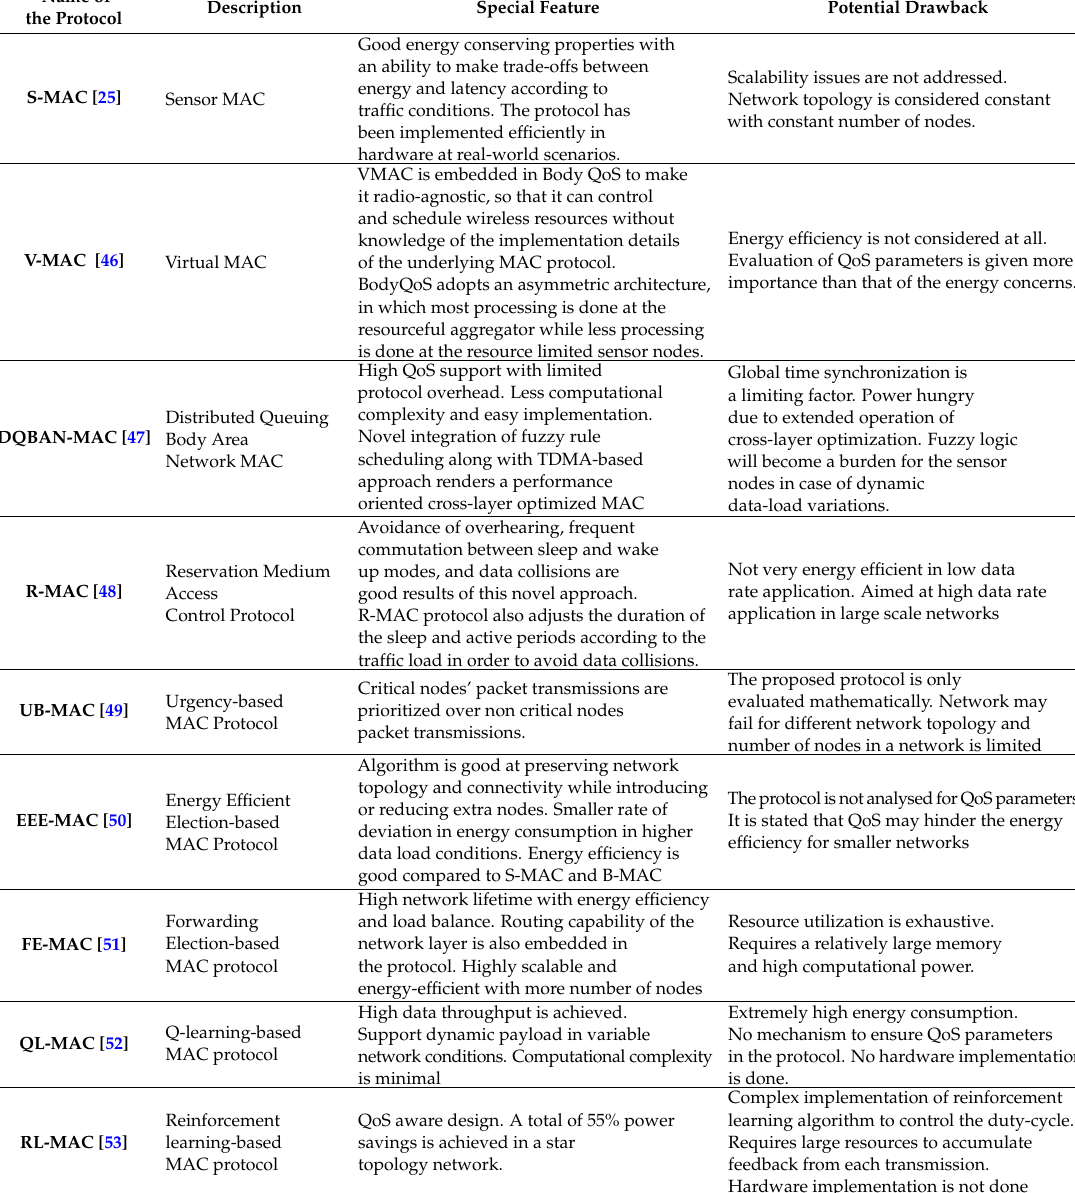
Table 8. Hybrid MAC protocols without WuR and their drawback for